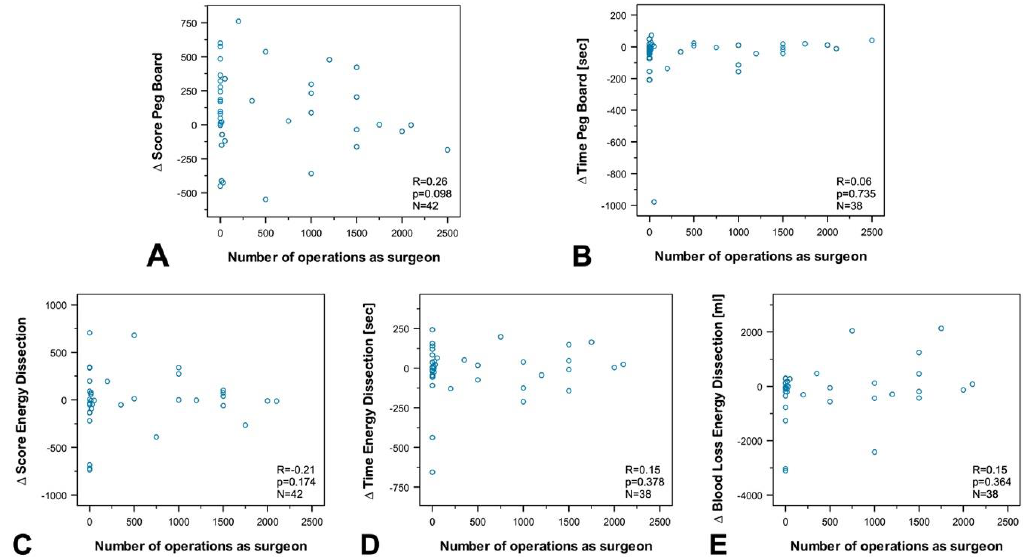
Figure 5. Correlation analysis between the number of minimally invasive operations as a surgeon and ( A ) ∆ Final Score in Peg Board, ( B ) ∆ Time to complete Peg Board, ( C ) Final Score Energy Dissection, ( D ) ∆ Time to complete Energy Dissection, and ( E ) ∆ Blood Loss Energy Dissection. No significant correlation was registered for any of the values (correlation coefficient: R, statistical significance: p, number: N).